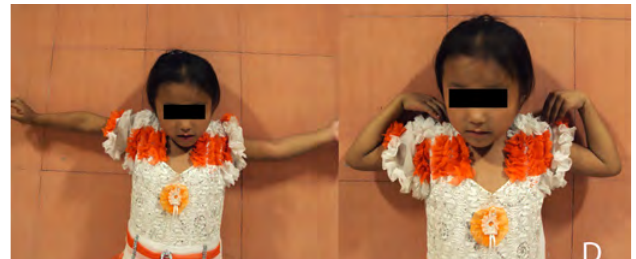
Fig 1 : A. Preoperative radiographs of 7 yrs girl with floating elbow